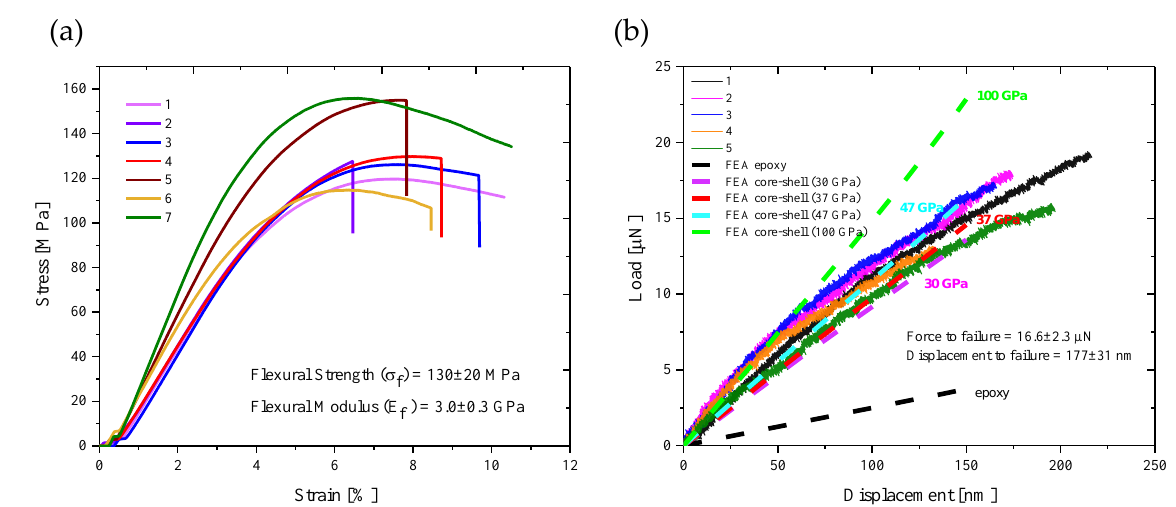
Figure 2. Flexural bending results. ( a ) Stress-strain curves of macroscopic specimens (50 × 12.5 × 1 mm 3 , length × width × thickness). Average flexural strength (UTS) σ f = 130 ± 20 MPa, flexural modulus E f = 3.0 ± 0.3 GPa; ( b ) nanoscale bending test results of five representative epoxy specimens. From the load-displacement curves, the average load at failure was 16.6 ± 2.3 µN, and average displacement at failure was 177 ± 31 nm. The FEA simulation results of pure epoxy and ‘core-shell composite’ with four different modulus values of the shell (30, 37, 47, and 100 GPa) are represented by the dashed lines.